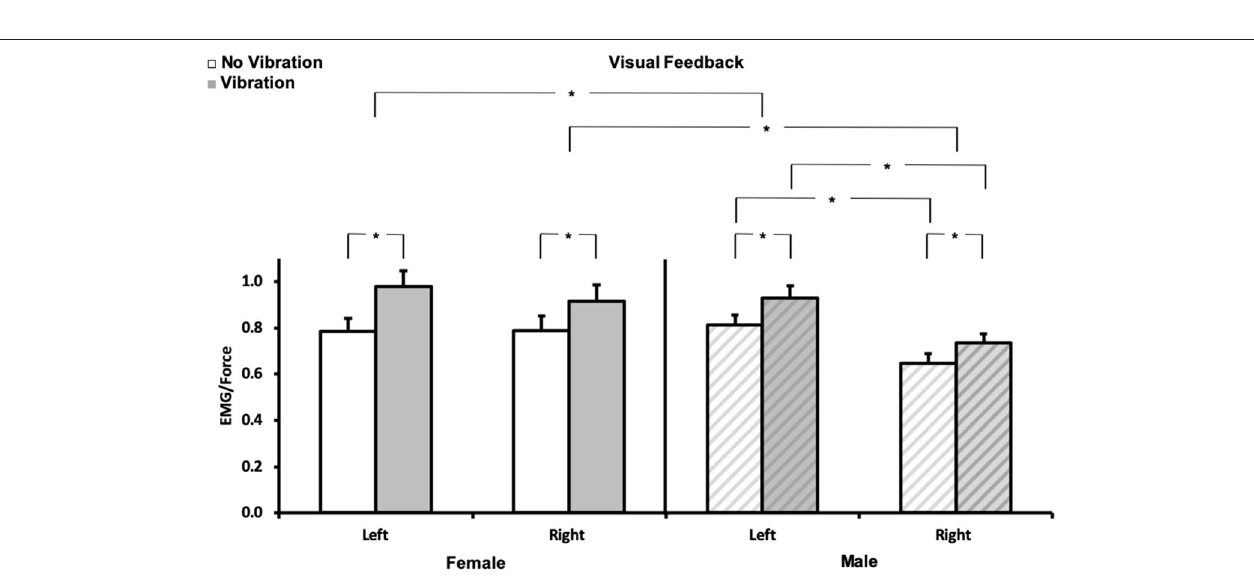
FIGURE 2 | Normalized EMG/force. Mean ( ± SE) for each hand (left and right) for no vibration ( ) and vibration ( ) for females ( N = 10, left panel), and males ( N = 10, right panel ). * p < 0.05. Each variable (EMG, force) was normalized to its corresponding 100% MVC. The required force exertion was 20% MVC.